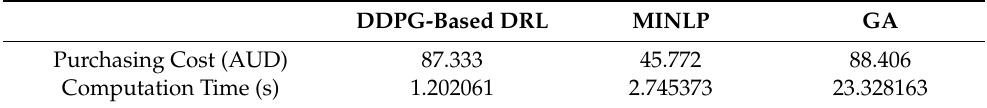
Table 5. Result Table 5. Result comparisons.